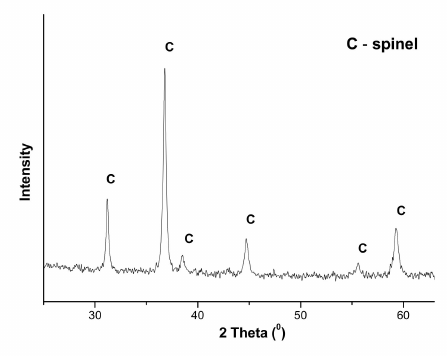
Figure 6. XRD patterns of Cs/Ni-Co sample.